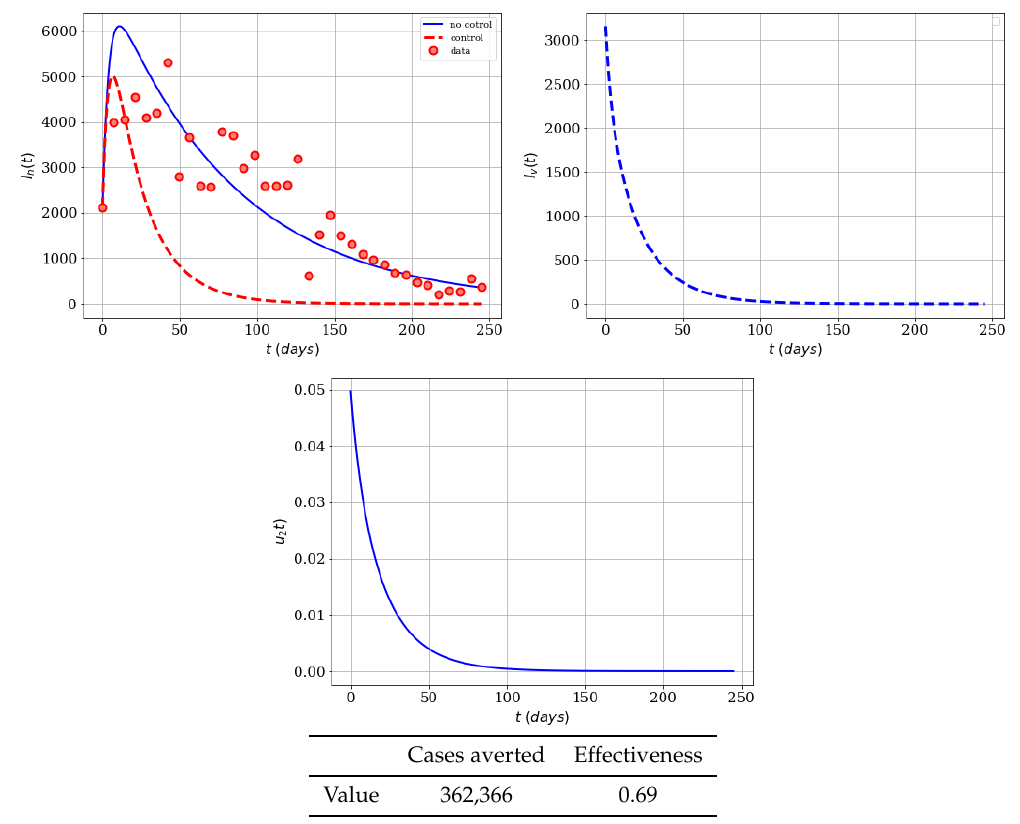
Figure 4. Numerical simulation of insecticide (spraying) campaign ( κ 1 = 0.1, u 2 max = 0.5) on the infected humans of the Zika mathematical model (1). Results regarding effectiveness are given in the table. The dots represent the real cases of infected people in Colombia for